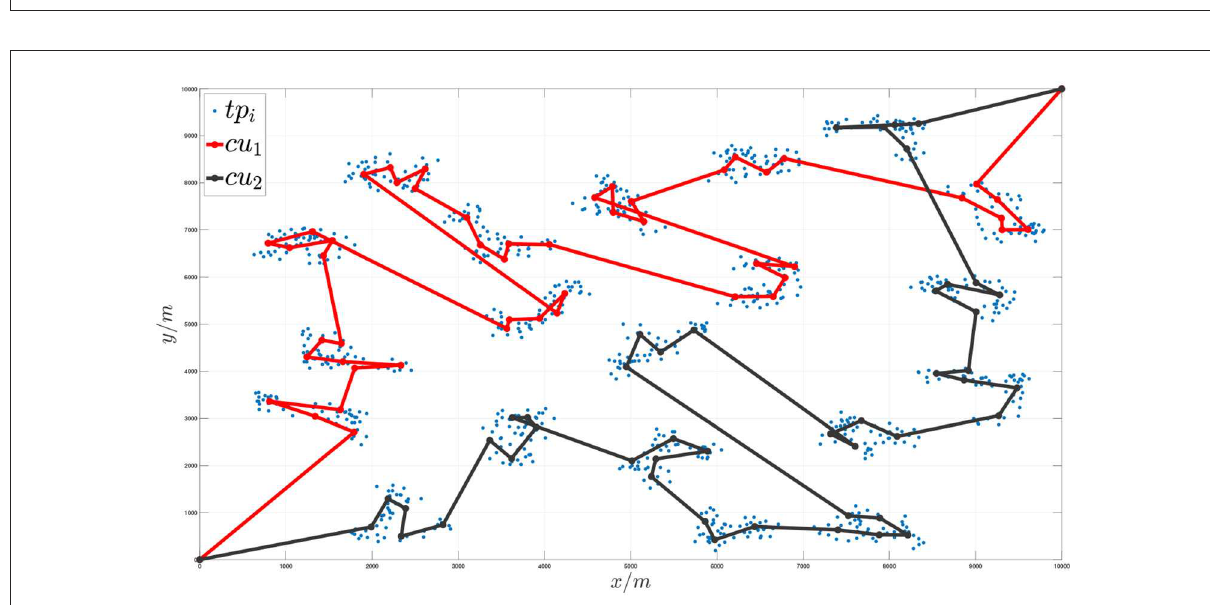
FIGURE8 Schematic diagram of the communication unit cooperative access node sequence when the number of target task nodes is 1,000.